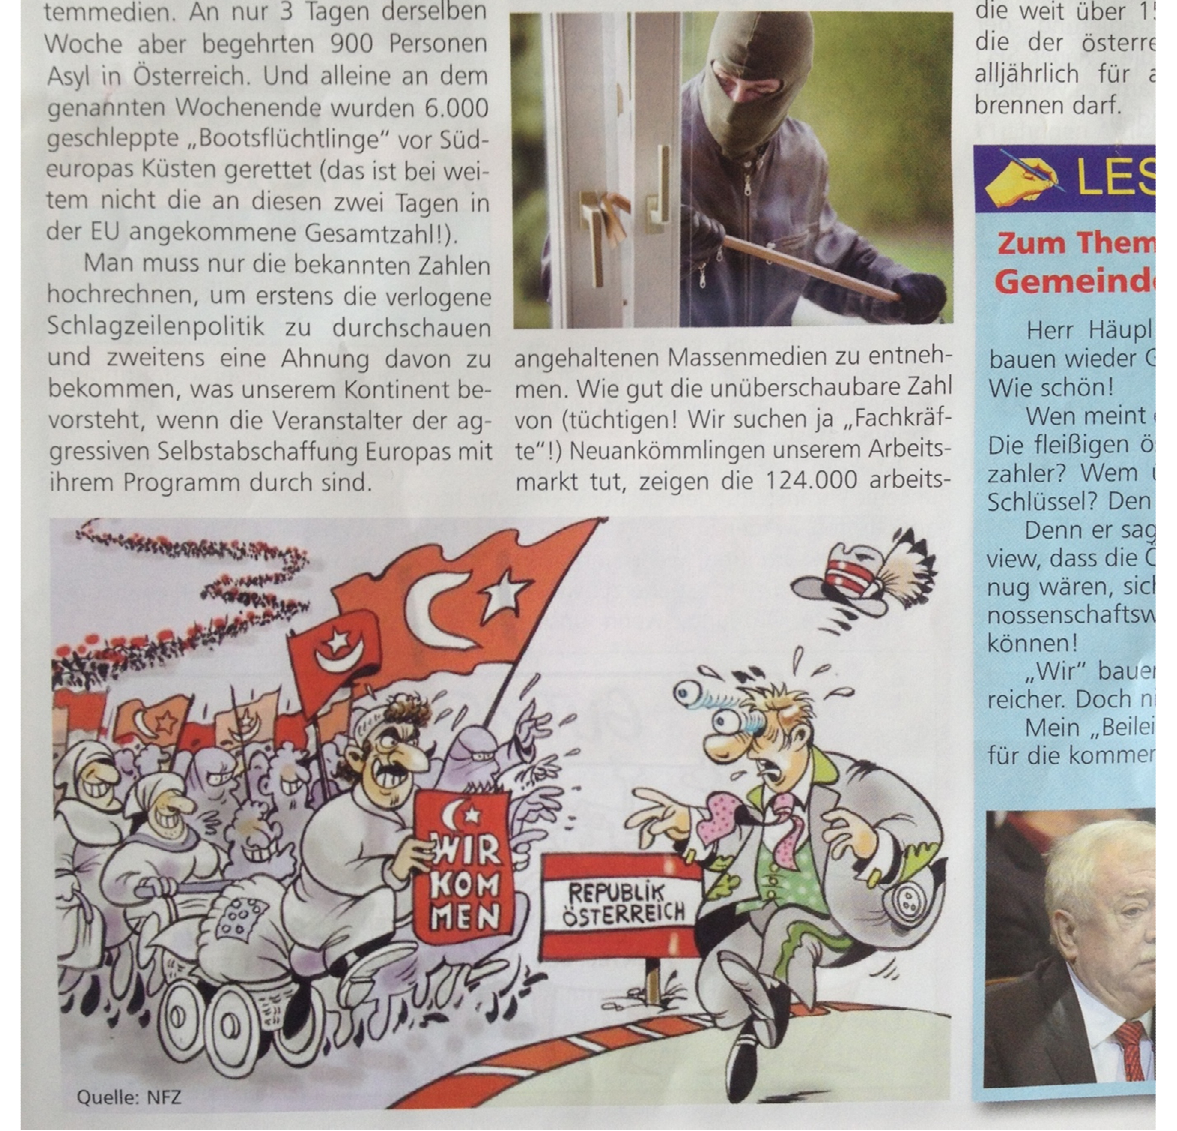
Figure 1. Freedom Party of Austria ( Freiheitliche Partei Österreichs; FPÖ) Brigittenau Pamphlet (FPÖ Brigittenau 2015, p. 9) .